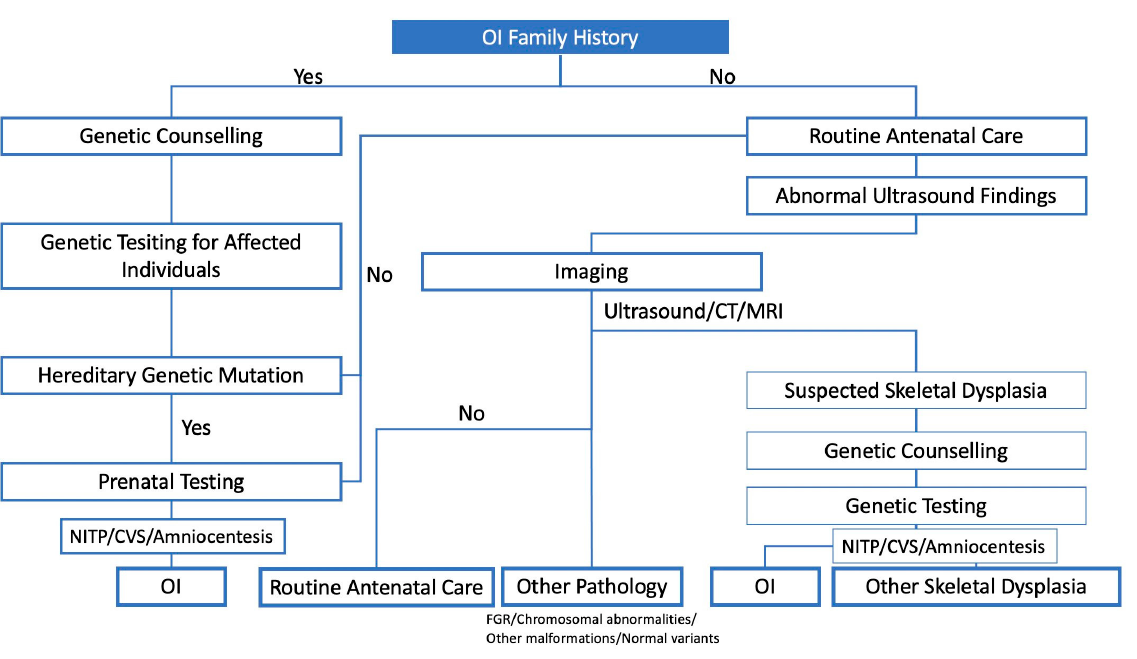
Figure 1. Prenatal diagnostic strategy for OI.